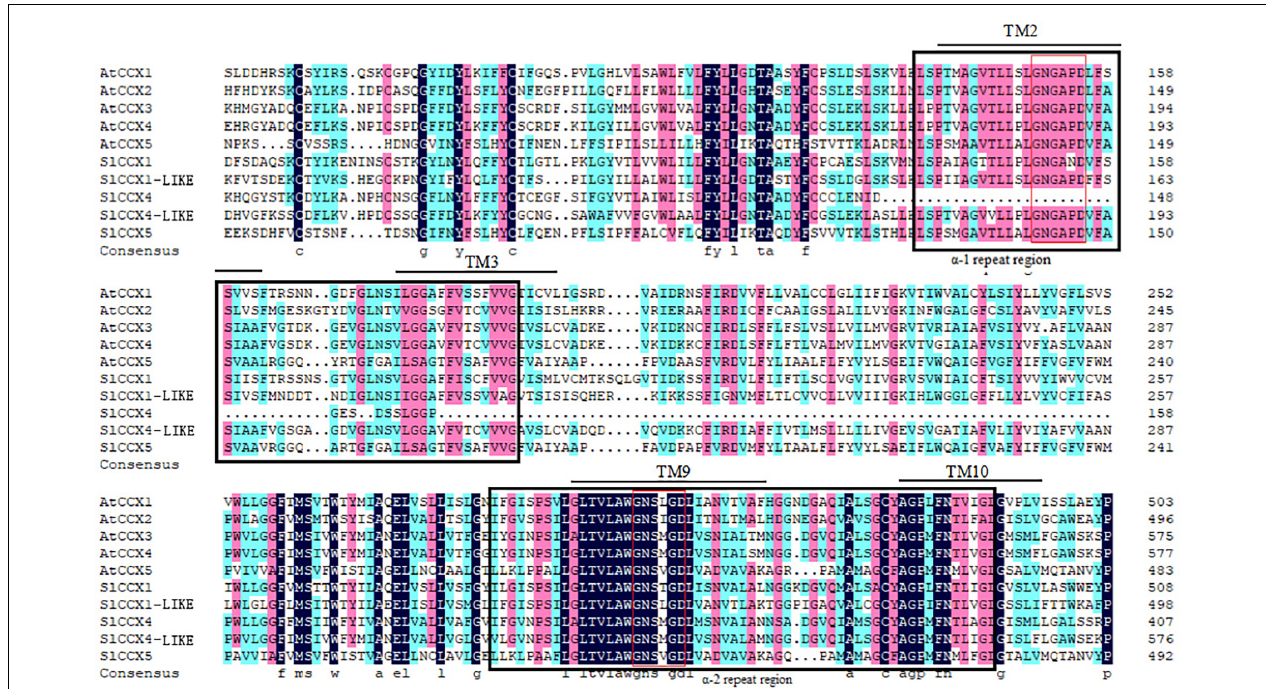
FIGURE 3 | Multiple sequence alignment of CCX proteins. Figure shows alignment of CCX protein sequences of Arabidopsis and tomato. Conserved α 1- and α 2-repeat regions are shown in black-colored boxes. The common conserved domain “GNG(A/S)PD” in α 1-repeat and “G(N/D)SxGD” in α 2-repeat motif are shown in red lines. The predicted transmembrane (TM) spans are shown in black color